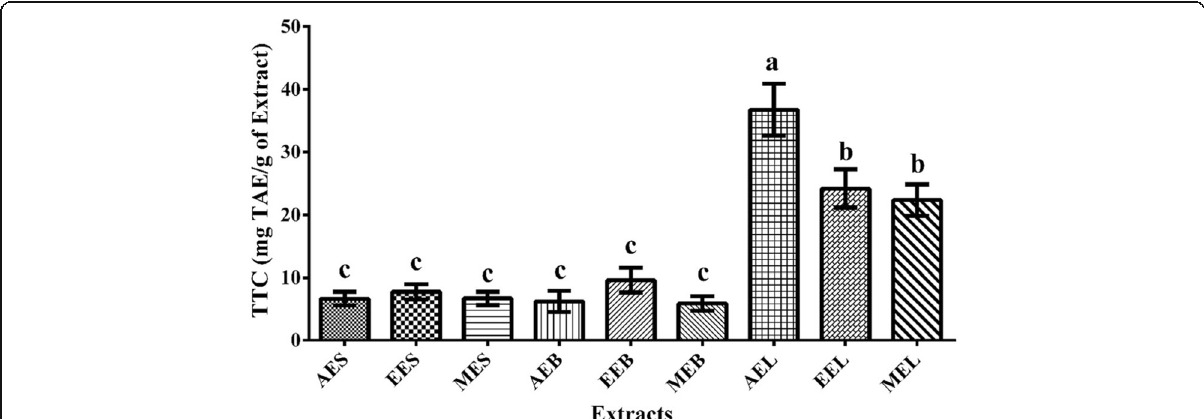
Fig. 3 Total tannin content expressed as mg TAE (tannic acid equivalent)/g of extract in different extracts of B. orellana . Bars with different letters are significantly different according to Tukey ’ s HSD tests ( P < 0.05). TTC = total tannin content; AES = aqueous extract (seed); EES = ethanolic extract (seed); MES = methanolic extract (seed); AEB = aqueous extract (branch); EEB = ethanolic extract (branch); MEB = methanolic extract (branch); AEL = aqueous extract (leaf); EEL = ethanolic extract (leaf); MEL = methanolic extract